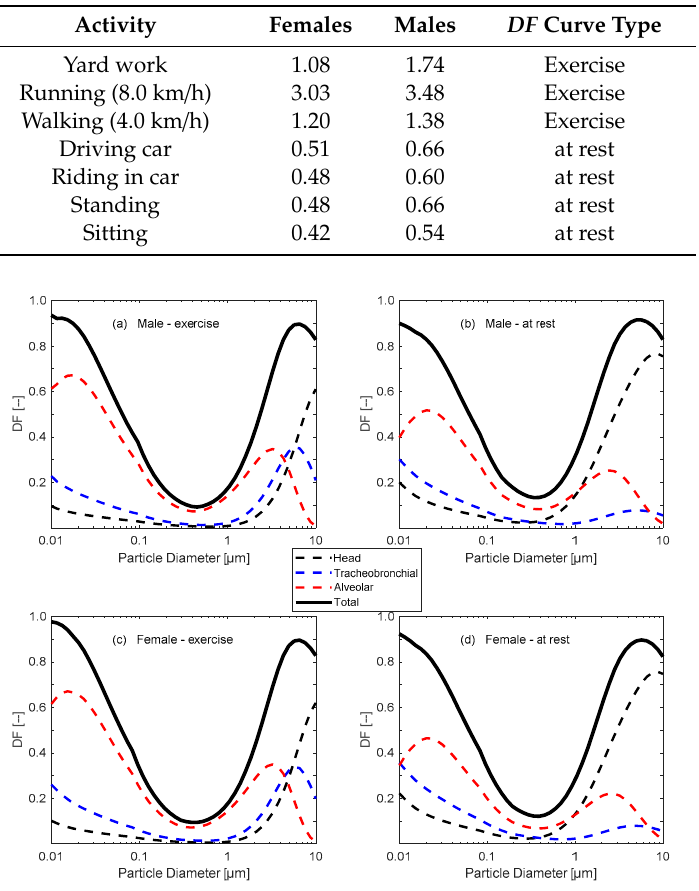
Figure 1. Size-resolved deposition fraction ( DF ) curves inside the respiratory tract of adult subjects: ( a ) males exercising, ( b ) males at rest, ( c ) females exercising, and ( d ) females at rest. Data was adopted from Löndahl et al. [23] and the ICRP and MPPD models.